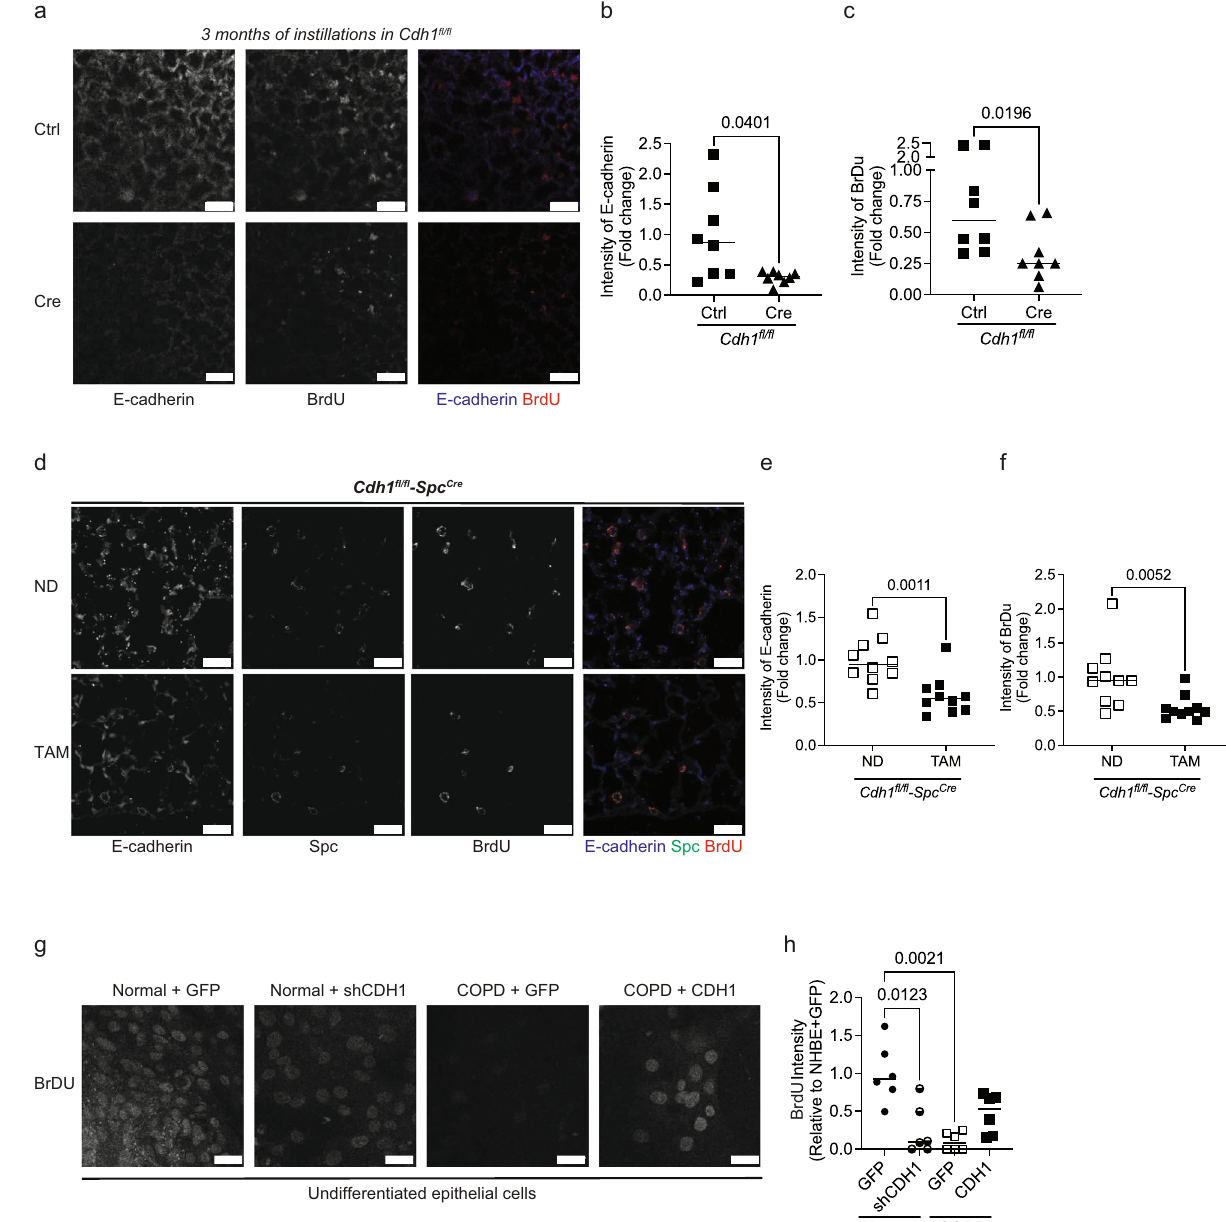
Fig. 3 Knockdown of E-cadherin decreases the regeneration of epithelium in the mice lungs. Regeneration of epithelium was assessed by BrdU staining. (a) Representative image at 10X (scale bar of 50 µ m) of Cdh1 fl / fl mice instilled with adeno-Cre recombinase (Ad5CMVCre-eGFP) to knockdown E-cadherin for 3 months shows decreases in BrdU as compared to Cdh1 fl / fl instilled with adeno-Ctrl (Ad-5CMVeGFP). Decreases in the fl uorescence intensity of b E-cadherin and c BrdU in Cdh1 fl / fl mice instilled with adeno-Cre as compared to Cdh1 fl / fl mice instilled with adeno-Ctrl. Data is generated from eight mice. To knock down E-cadherin in the AT2 cells of mice lungs, Cdh1 fl / fl -Spc Cre mice were fed tamoxifen (TAM) for 30 days. These were compared to Cdh1 fl / fl - Spc Cre mice receiving a normal chow diet (ND). In vivo knockdown of E-cadherin in Cdh1 fl / fl -Spc Cre mice show decreases in BrdU expression as observed in the d representative images at 10X (scale bar of 25 µ m), with decreases in the intensity of e E-cadherin and f BrdU in AT2 cells. Data is generated from fi ve mice. Undifferentiated normal basal epithelial cells were transfected with Ad-GFP-U6-h-CDH1-shRNA to knock down E-cadherin, and undifferentiated COPD cells were transfected with Ad-GFP-U6-h-CDH1 to overexpress E-cadherin. We compared to respective undifferentiated Normal/COPD with Ad- GFP. g Representative image at 40× (scale bar of 25 µ m) and h quanti fi cation showing decreased BrdU intensity in the normal epithelium with E-cadherin knockdown (Normal + shCDH1) and COPD at baseline (COPD + GFP) as compared to Normal + GFP. Also, COPD with overexpressed E-cadherin (COPD + CDH1) demonstrates increased BrdU intensity compared to COPD + GFP. Data are expressed as median bars and generated from three inserts from two